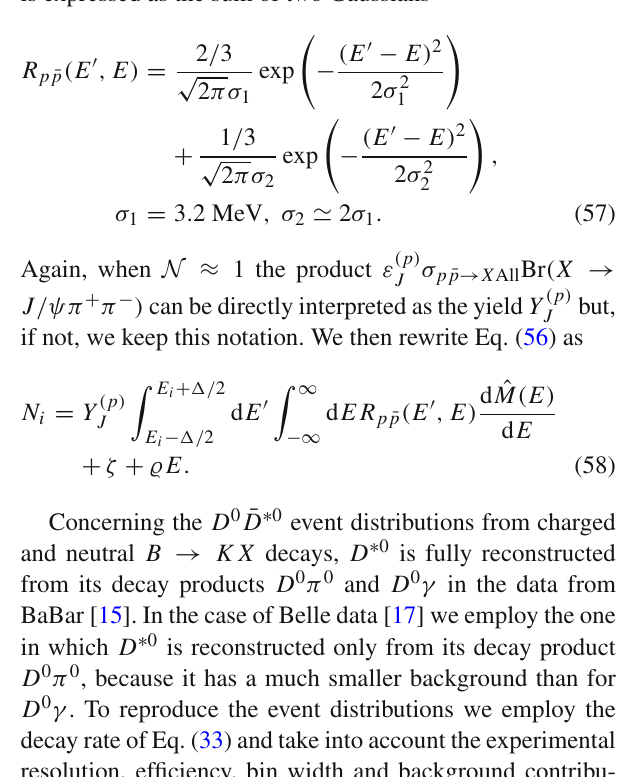
Table 1 The B decays into K J /ψπ + π − and D 0 ¯ D ∗ 0 channels are number of points included in the fits are also indicated. For the inclusive p ¯ p collision measured by the CDF Collaboration [18] we account for both measured by the BaBar [14,15] and Belle Collaborations [16,17]. The total number of B ¯ B pairs ( N ), bin width ( (cid:17) ), and the Gaussian similar parameters, but now the luminosity ( L ) is given instead of N B ¯ B width ( σ ) used in the experimental resolution function are given. The For more details see the text B → K X BaBar